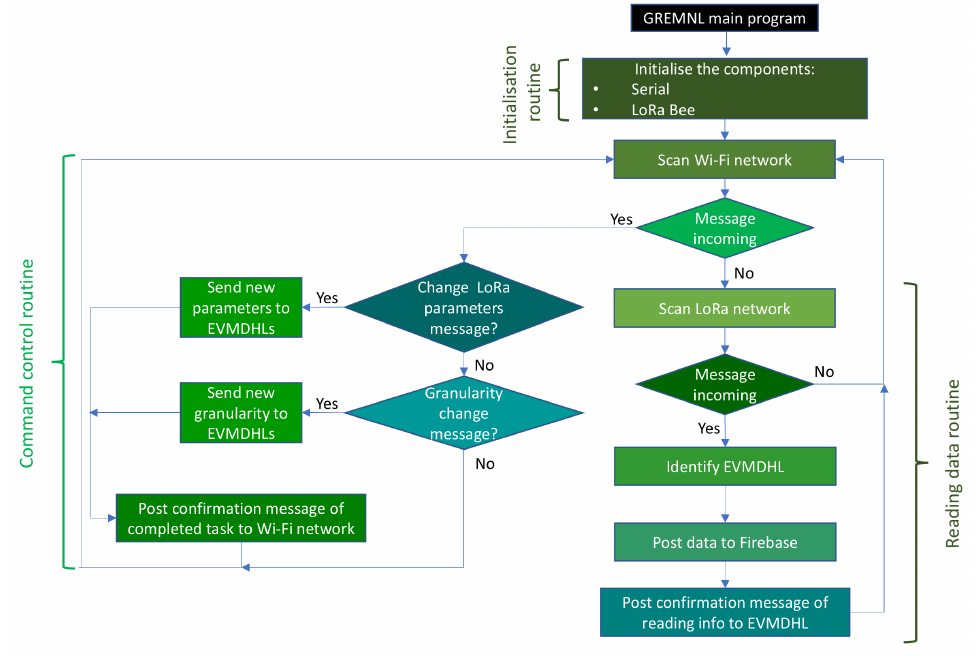
Figure 8. Flowchart of the main program for the